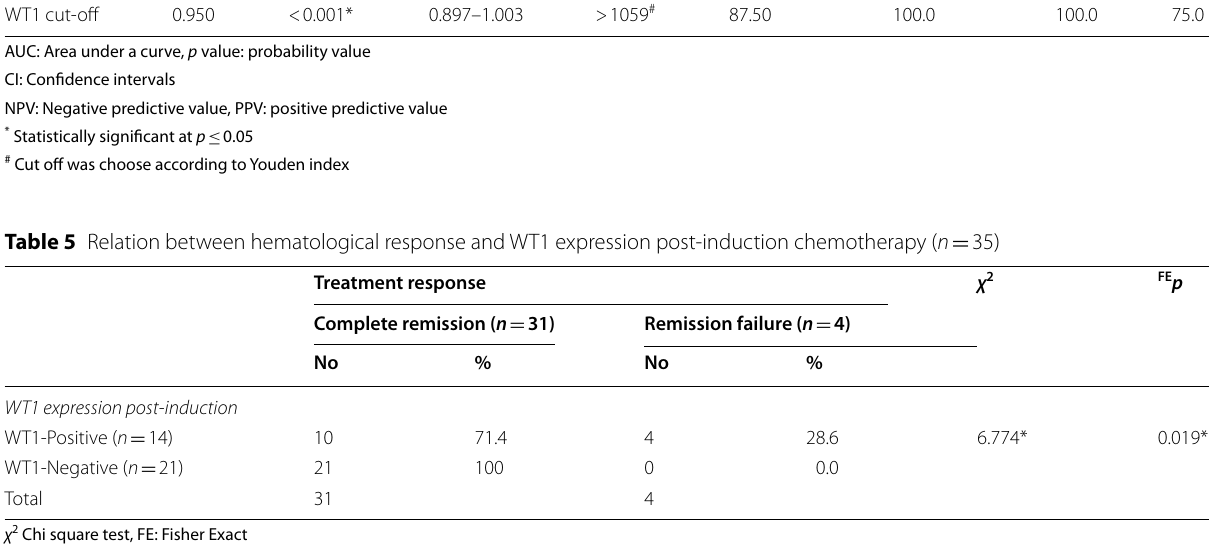
χ 2 Chi square test, FE: Fisher Exact p : p value for association between different categories *